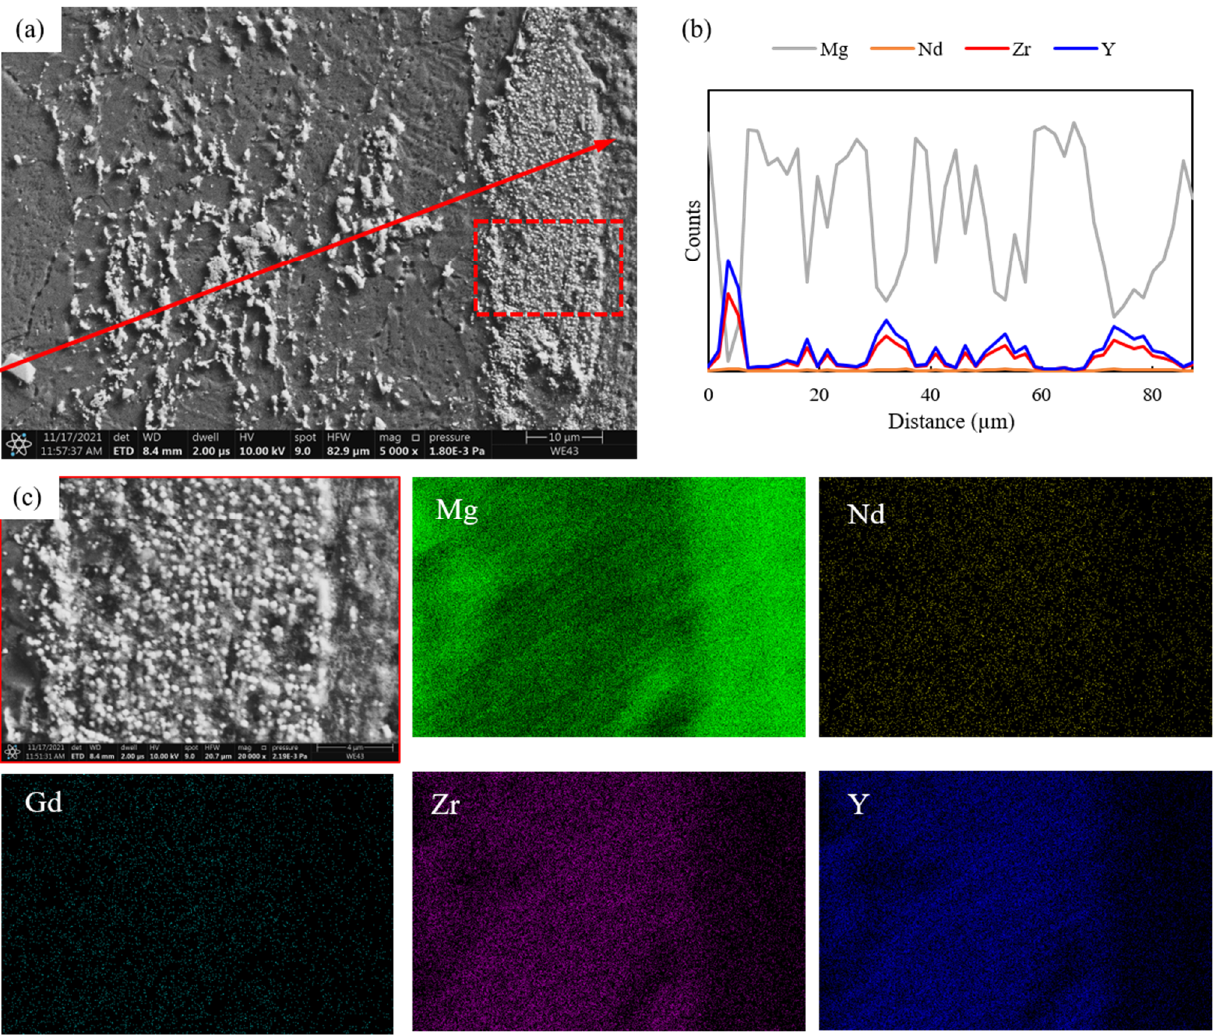
Figure 4. ( a ) SEM image of rod’s edge and ( b ) elemental compositional analysis across line shown in ( a ). ( c ) EDS elemental maps of the precipitate cluster in the edge region. Figure 5 represents the friction stir-extruded rod core region (C) showing large grains. An SEM image of a core grain containing deformation bands is shown in Figure 5a. The